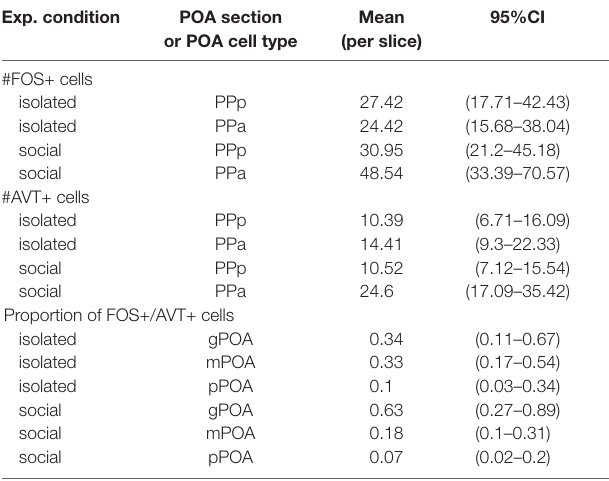
TABLE 1 | Summary of main results for FOS+, AVT+ and FOS+/AVT+ cells quantification in POA sections per experimental conditions. Exp.